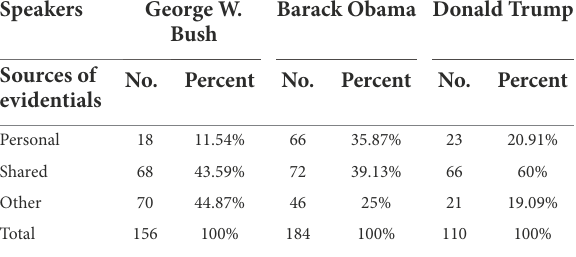
TABLE 1 The distribution of sources of evidentials in three cases. Speakers